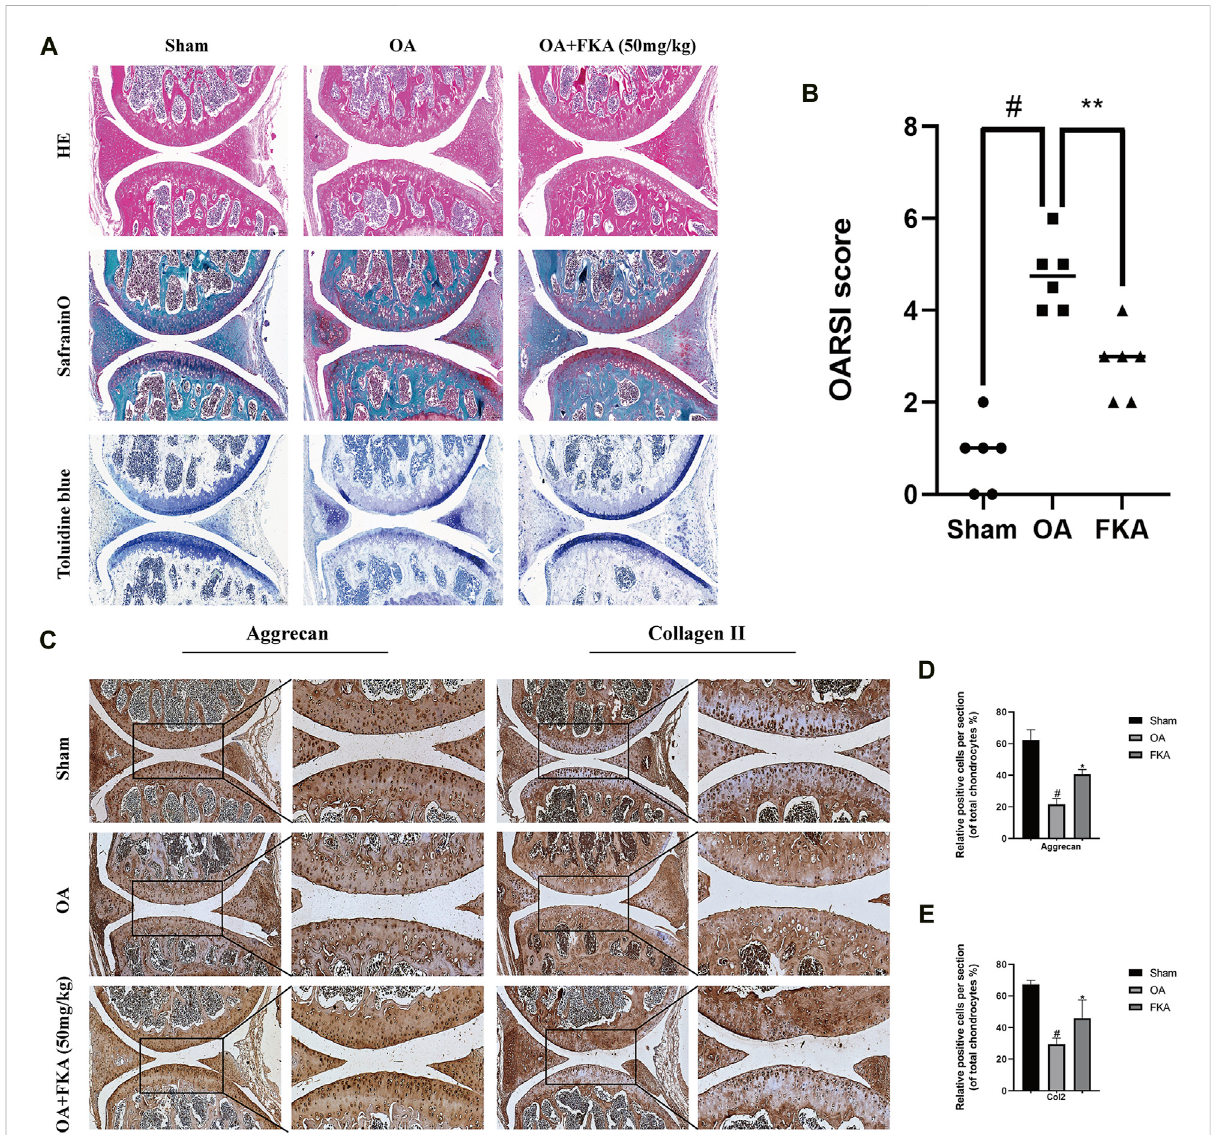
FIGURE 9 Impacts of FKA on mouse OA model (A) H&E, safranin, and toluidine blue staining of cartilage in the mouse OA model. (B) Osteoarthritis Research Society International (OARSI) scoring system (C) Immunohistochemistry staining of the expression of Aggrecan and Col2 were conducted on three groups of cartilage tissues (scale bars, 50 and 100 μ m). (D and E) Quantitative analysis of immunohistochemistry. The values are presented as means ± SD ( n = 6). # p < 0.05 vs sham group; * p < 0.05 vs OA